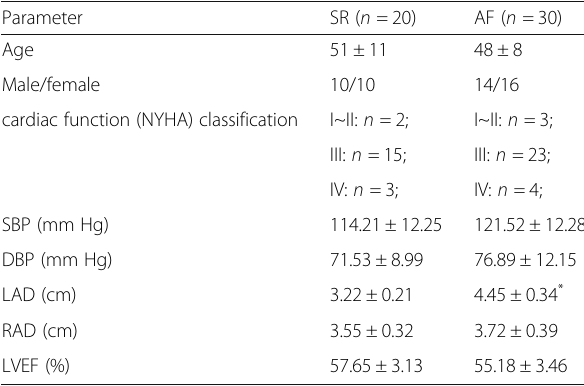
Table 1 General clinical data of the patients in the two